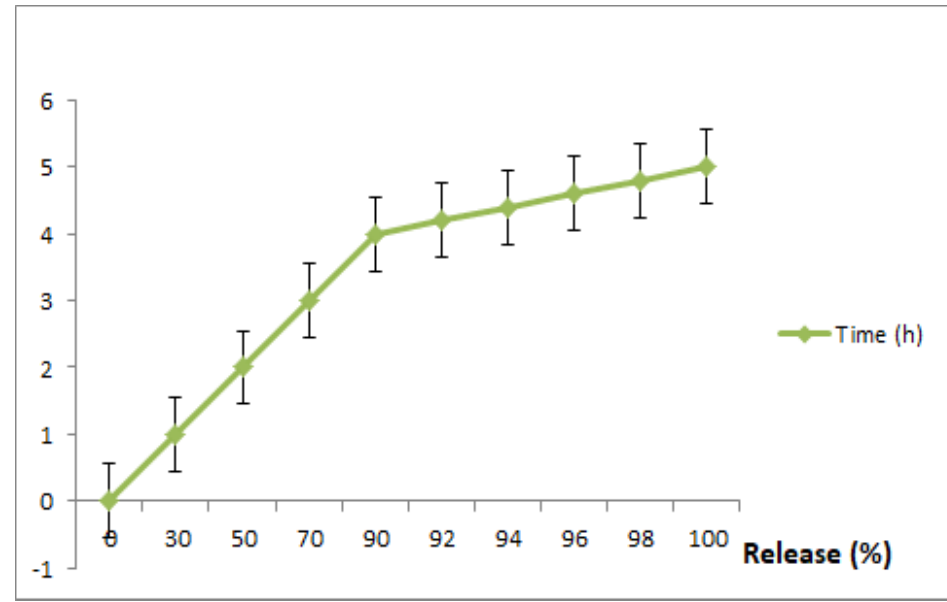
Figure 5. In vitro drug release of the prepared Ru III /Q complex, in slightly basic phosphate buffer saline at 37 °C. Data are represented as mean ± SD (n = 3).